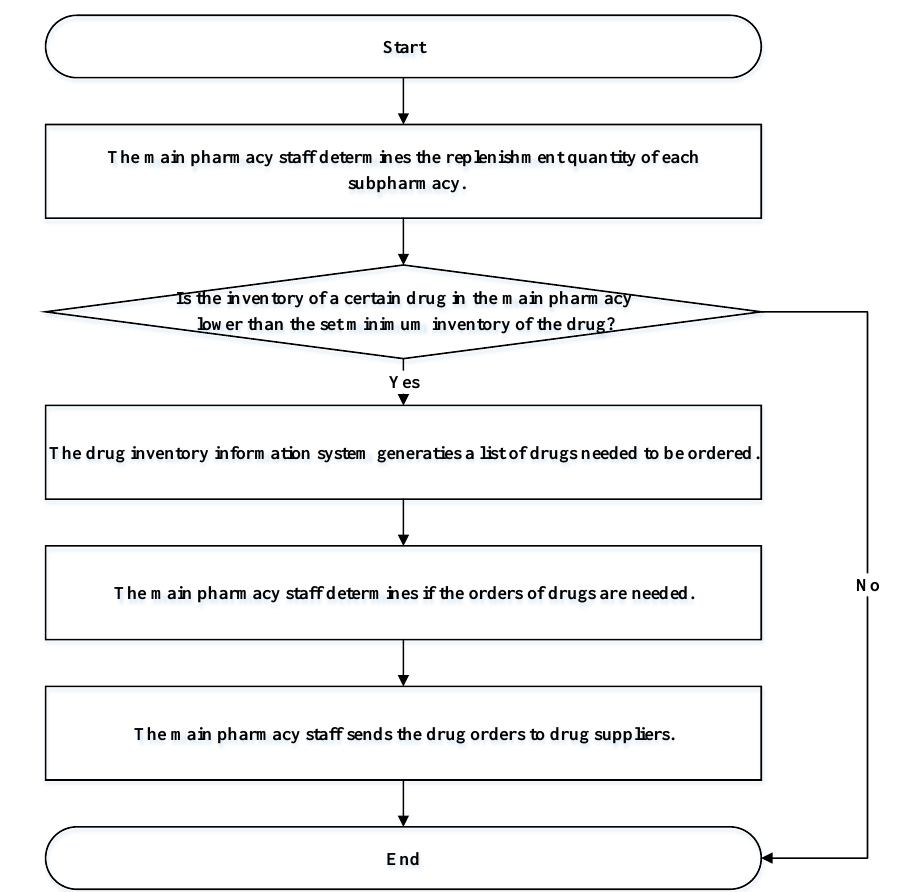
Figure 3. The main pharmacy ordering process.